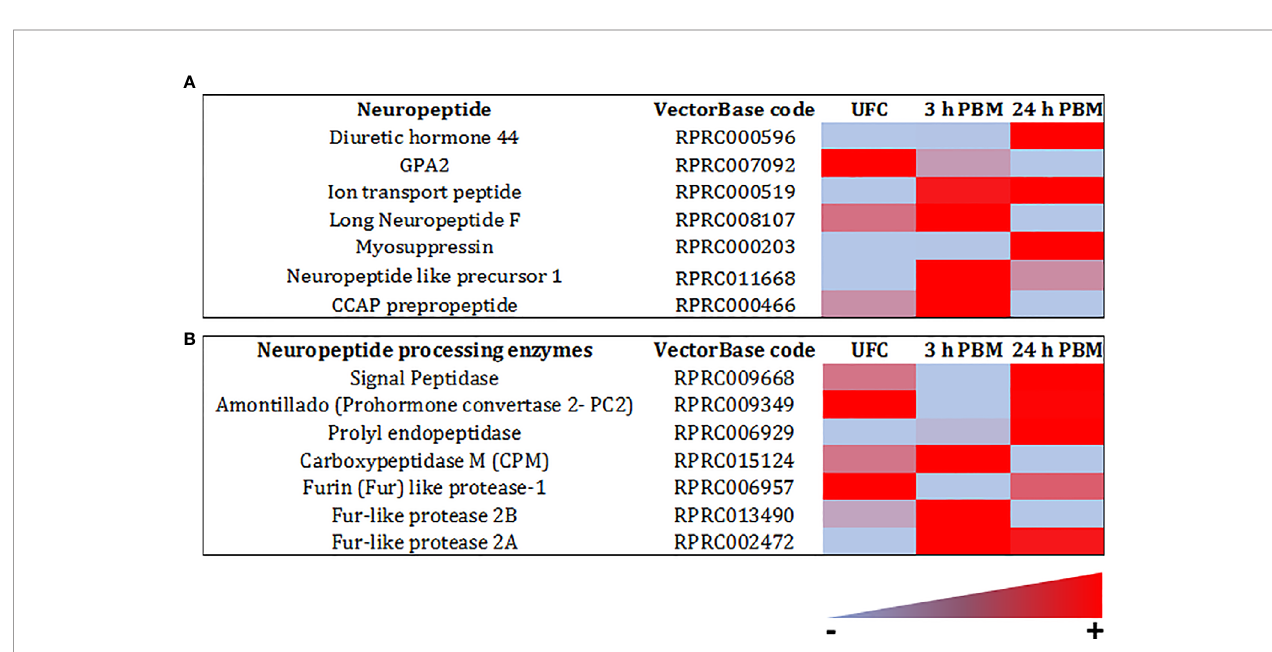
FIGURE 8 | Heat map comparing the mRNA expression levels of (A) neuropeptides, and (B) neuropeptide processing enzymes in Malpighian tubules from insects unfed (UFC), 3 h and 24 h post blood meal (PBM). The input data is the readcount value from gene expression level analysis after normalization and is presented by means of a color scale, in which light blue/red represent lowest/highest expression. DESeq was used to perform the analysis. Details of transcript expression are shown in Supplementary Worksheets 1 , 2 .